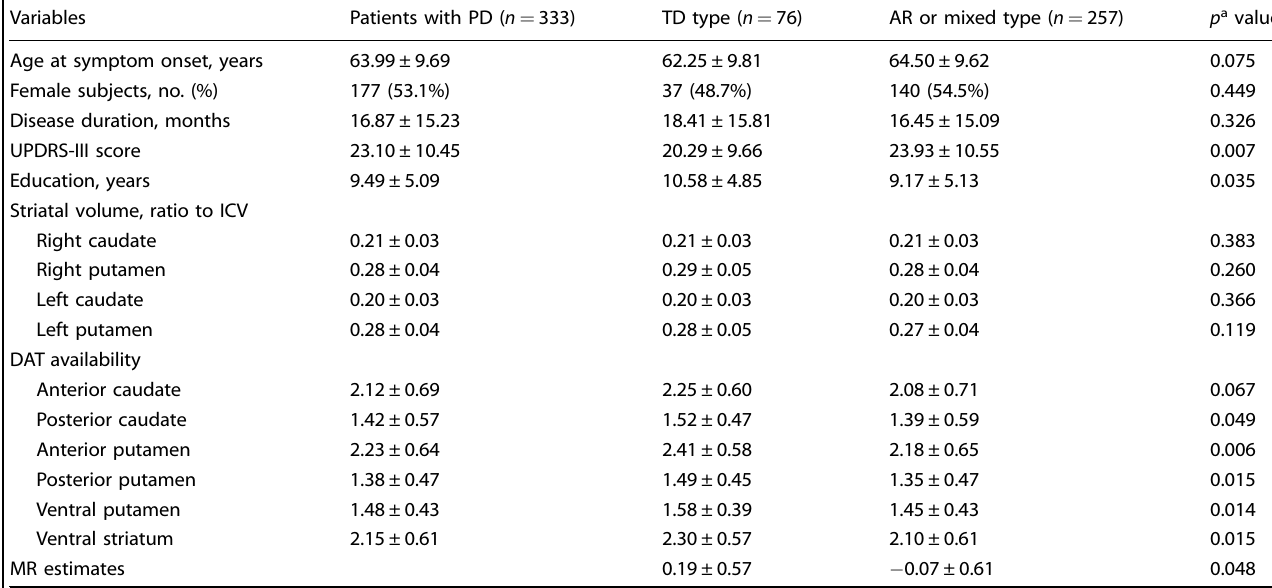
Table 1. Demographic characteristics.